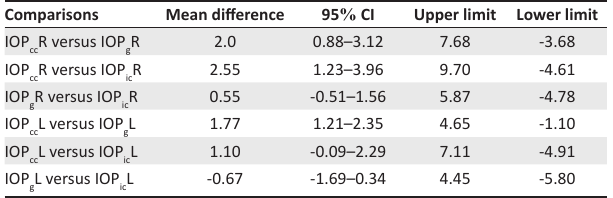
TABLE 2: Results of a repeated-measures analysis of variance for the right and left eyes. Comparisons